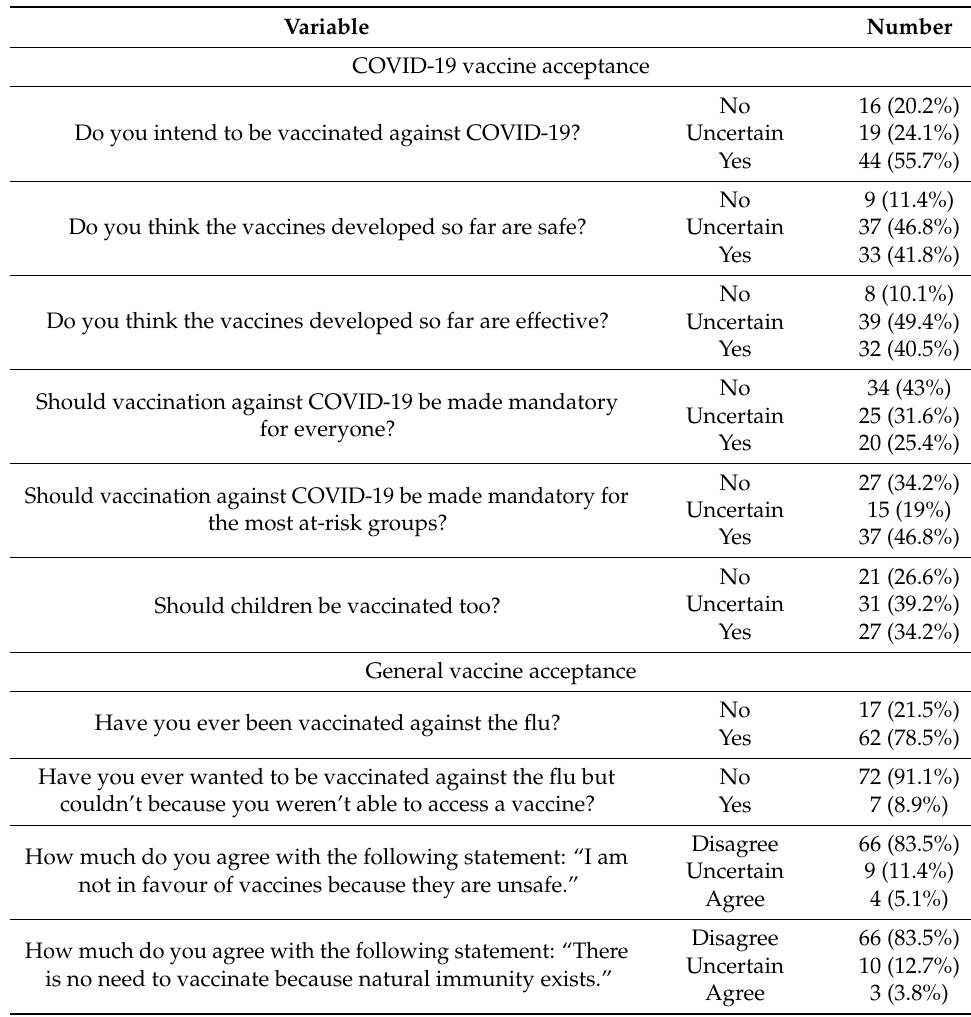
Table 2. Summarized findings on vaccine acceptance among younger rural